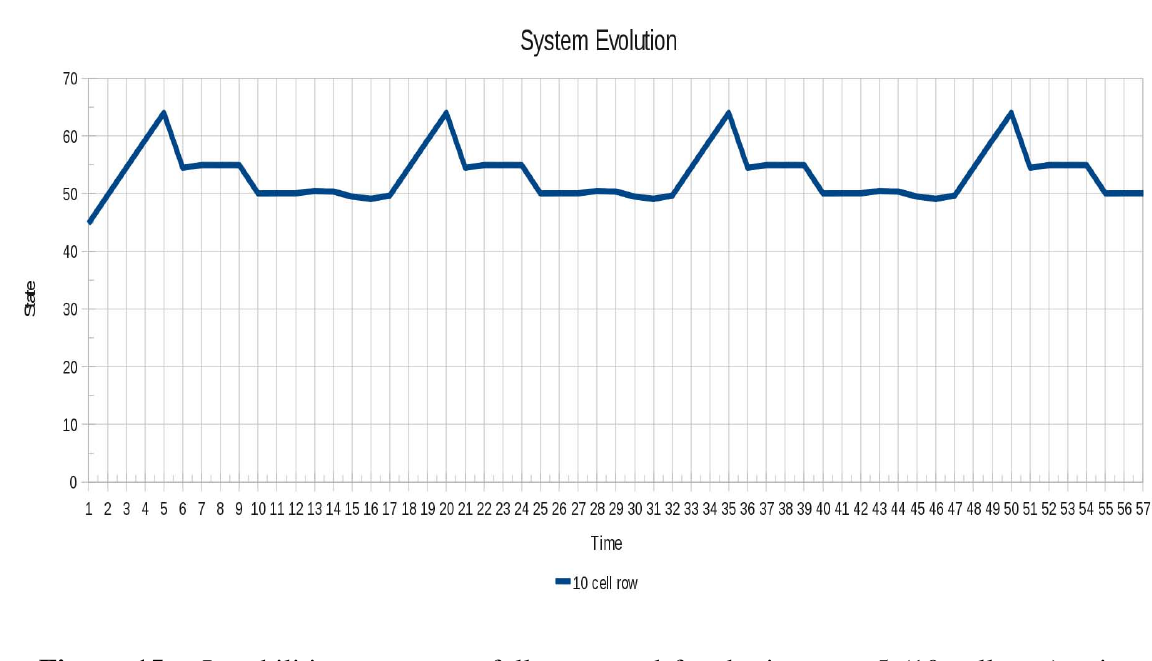
Figure 15. Instabilities are successfully removed for the instance 5 (10 cell row) using all